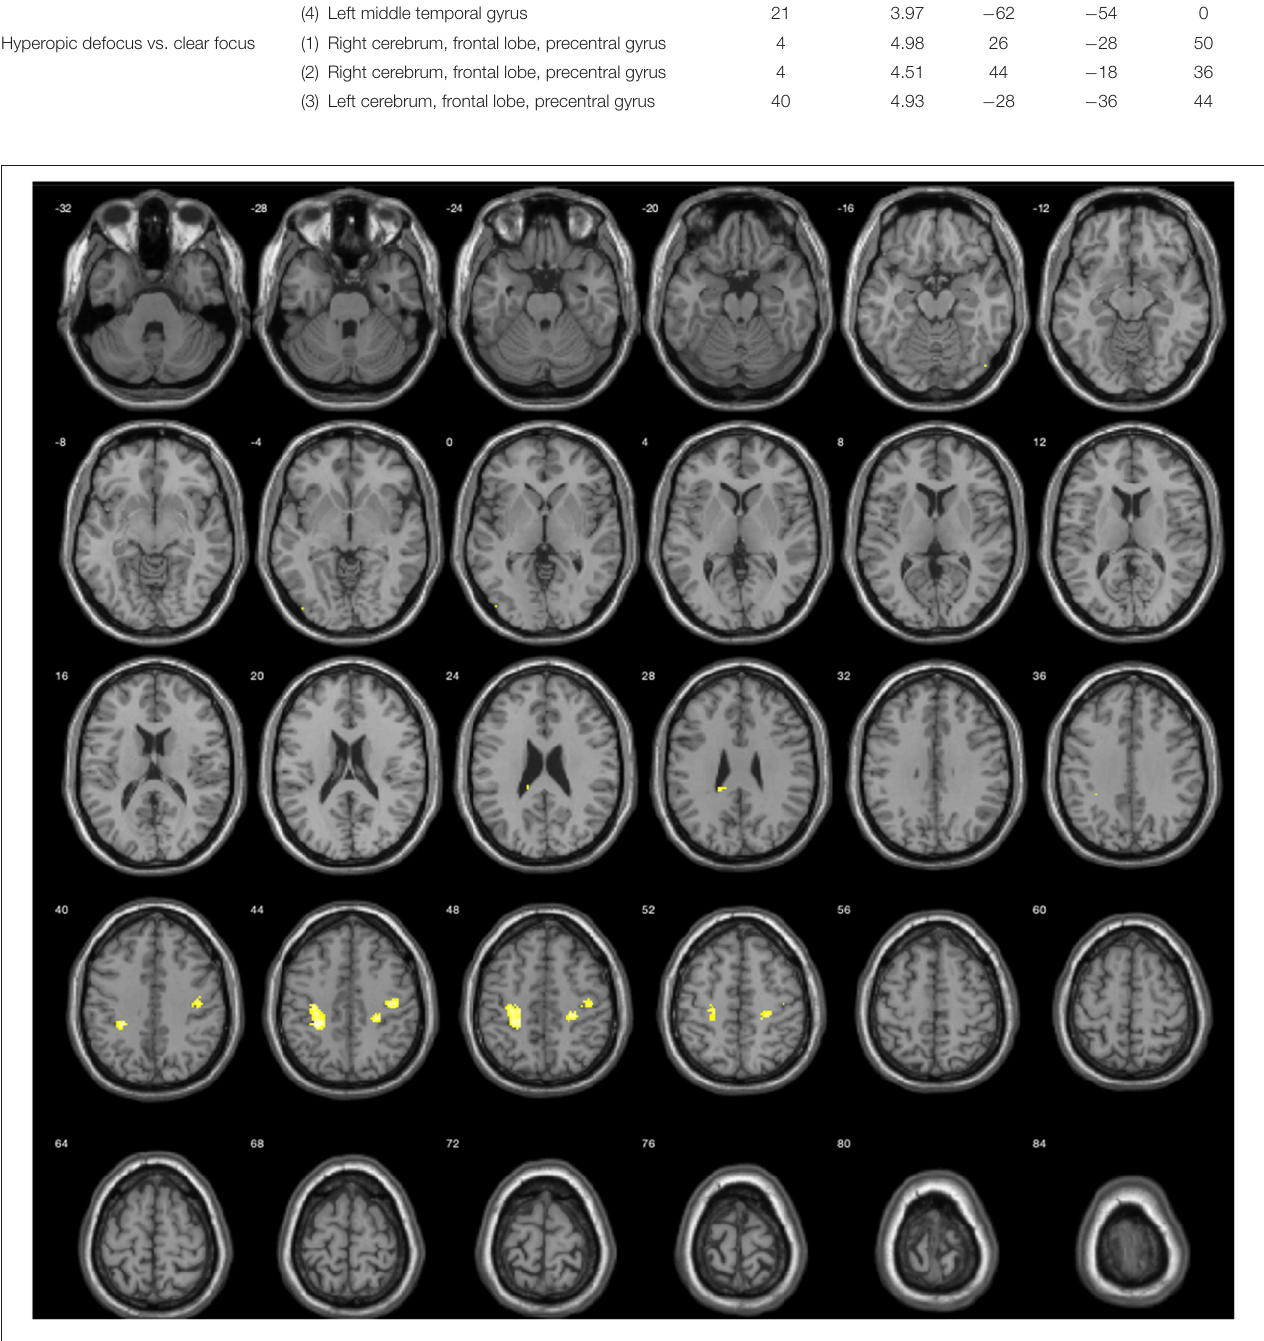
FIGURE 3 | Average activation maps resulting from group analysis, showing the increase of neural activation in hyperopic defocus relative to clear focus state. Color scale indicates score significance level.